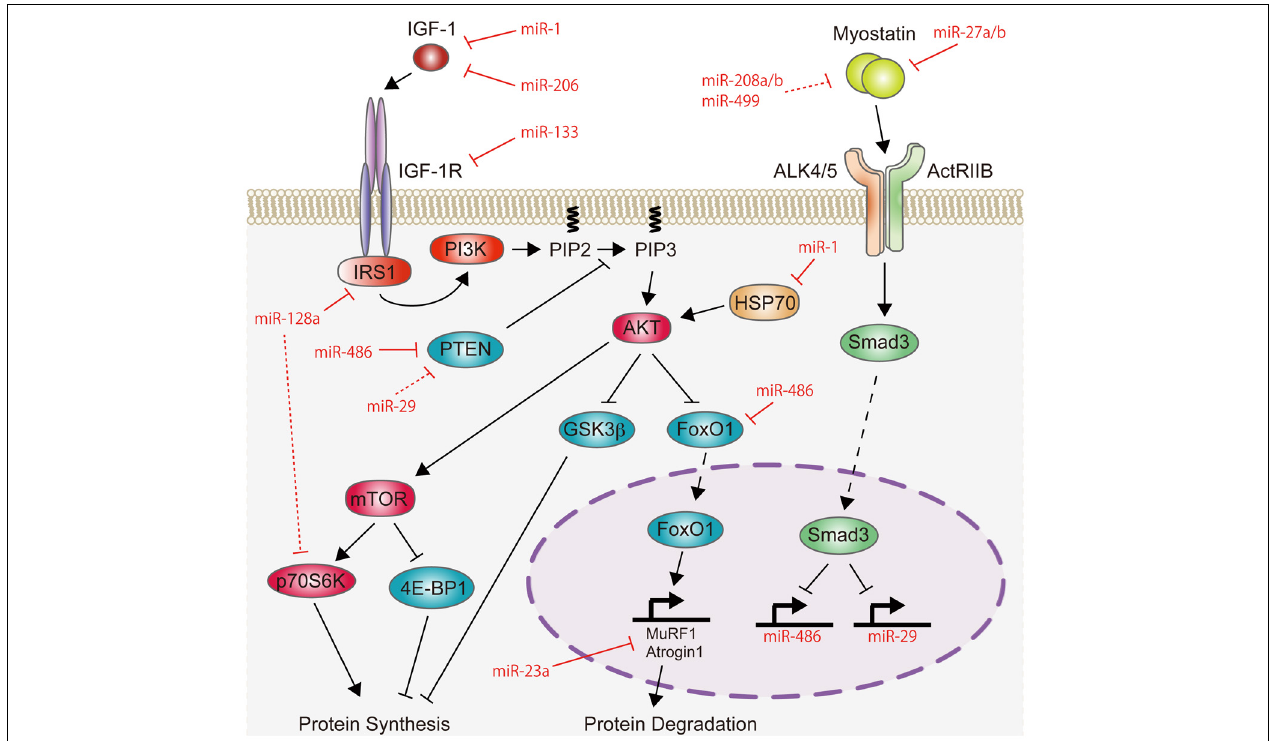
FIGURE 1 | Schematic representation of miRNAs involved in the regulation of the IGF-1/Akt pathway and myostatin signaling. IGF-1 increases the activity of Akt protein. This activation of Akt is attenuated by PTEN. The activated state of Akt stimulates protein synthesis through mTOR. Akt also inhibits protein degradation by suppressing the activity of GSK3 β and FoxO1, which induces protein degradation by activating the expression of MuRF1 and Atrogin1. Therefore, the IGF-1/Akt pathway induces skeletal muscle hypertrophy. Recent studies have shown that miR-1, miR-133, miR-206, and miR-128a negatively regulate the IGF-1/Akt pathway by targeting positive regulators of the IGF-1/Akt pathway (IGF-1, IGF-1R, IRS1,